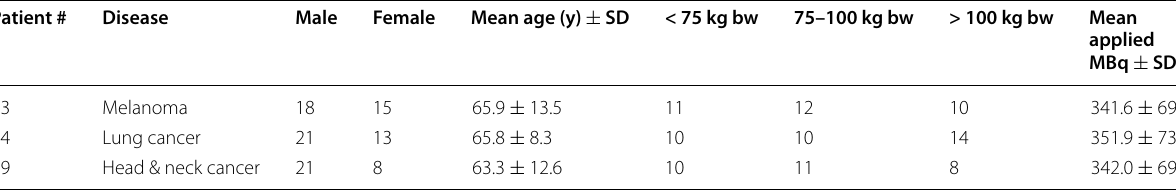
Table 1 Demographics of study population Patient